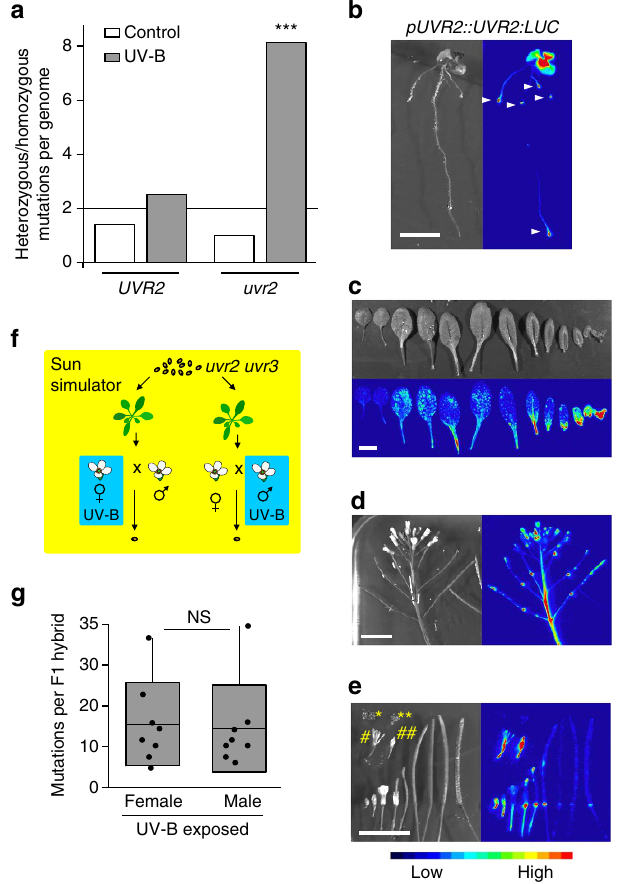
Figure 3 | Developmental aspects of mutagenesis by UV-B treatment. ( a ) Ratio of heterozygous versus homozygous mutations in UVR2 (wild-type, uvr8 , tt4 and uvr3 ) and uvr2 ( uvr2 and uvr2 uvr3 ) genotypes after one generation of control and UV-B treatment (300mWm (cid:2) 2 UV-B BE ). The 2:1 ratio (horizontal line) was expected if all inherited mutations occurred during somatic development. Mutations above this ratio were likely to originate after separation of male and female cell lineages. *** indicates statistically significant differences to all other samples in Fisher’s exact test, P o 0.001. ( b – e ) Expression of UVR2- LUCIFERASE translational fusion construct driven by endogenous promoter ( UVR2promoter::UVR2:LUCIFERASE ). Images on the top/left show plant tissues under white light and those on the bottom/right luciferase signal. All luciferase images were taken using identical exposure time of 1min, and colour scale at the bottom indicates signal intensity. ( b ) Ten-day-old in vitro grown plant. Arrowheads indicate luciferase signals in root apical meristems. Scale bar, 5mm. ( c ) Leaves dissected from 3-week-old A. thaliana plant organized from the oldest (left) to the youngest (right). Scale bar, 10mm. ( d ) Inflorescence. Scale bar, 10mm. ( e ) Flower, silique and seed developmental series. Bottom row, left to right: closed flower, flower with emerging pistil, fully opened flower, siliques at different stages and the last opened silique containing seeds with mature embryos. Hashes: pistils and anthers from (#) opened and (##) closed flowers. Petals and sepals were manually removed. Asterisks: (*) dry and (**) fresh seeds. Scale bar, 10mm. ( f ) Genetic test for sex specificity of UV-B-induced mutations. uvr2 uvr3 control and UV-B-irradiated plants (300mWm (cid:2) 2 UV-B BE ) were reciprocally crossed and the number of female- and male-specific mutations was analysed in progeny plants. ( g ) Boxes show genotype average (middle line), s.d. (left and right margins) and values outside of the s.d. range (horizontal bars) between eight analysed genomes (dots) per experimental point. NS, not significant (Student’s t -test, P ¼ 0.844).